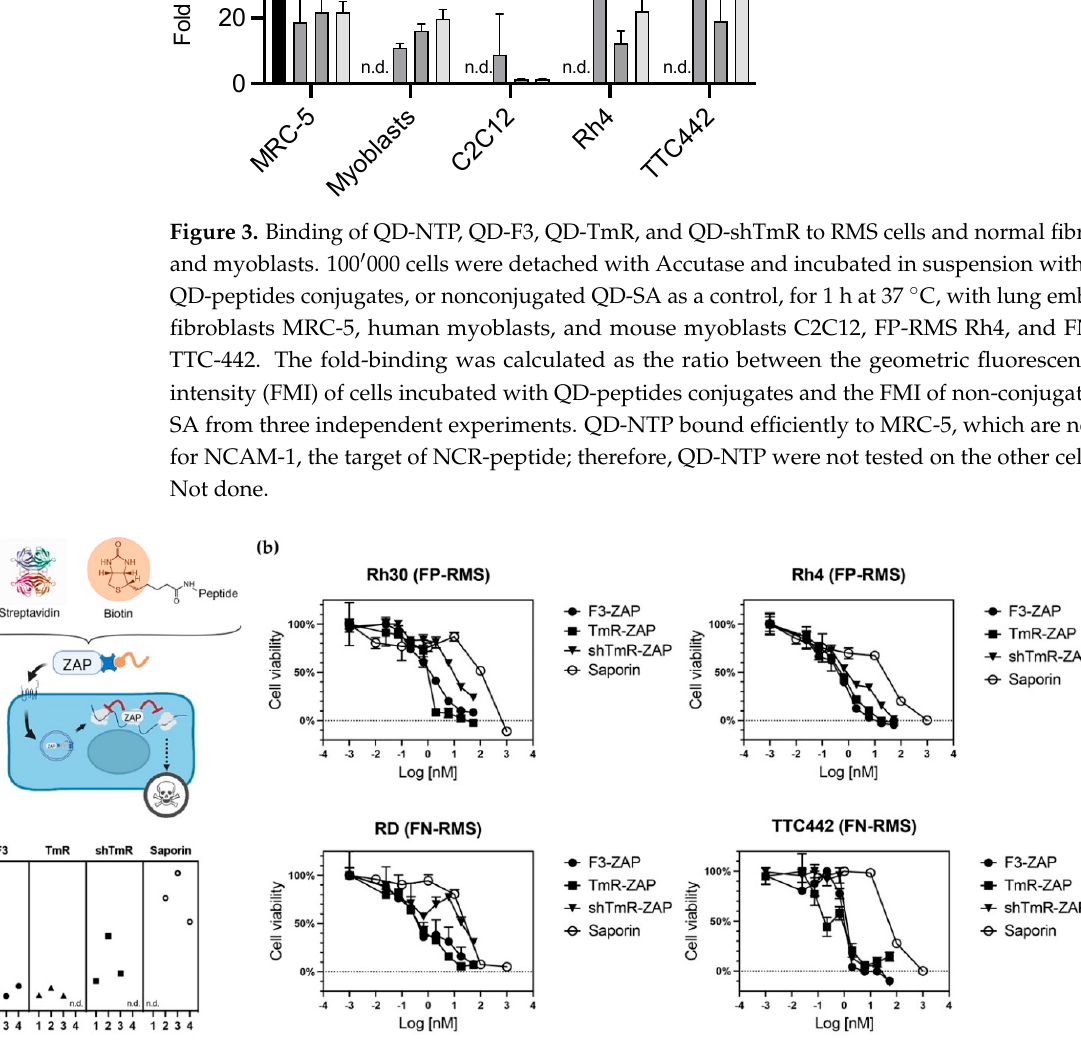
Figure 4. Efficient cytoplasmic delivery of Saporin by selected RMS-targeting peptides. ( a ) Structure and mechanism of action of peptides-Saporin conjugates. Ribosomes’ inhibition results in cell death. ( b ) RMS cells were treated with increasing concentrations of peptides-Saporin conjugates for 48 h, and cell viability was measured by the MTT assay. ( c ) Summary of IC 50 values calculated for Saporin alone and the different peptides-Saporin conjugates. 1: Rh30, 2: Rh4, 3: RD, 4: TTC-442. n.d.: Not